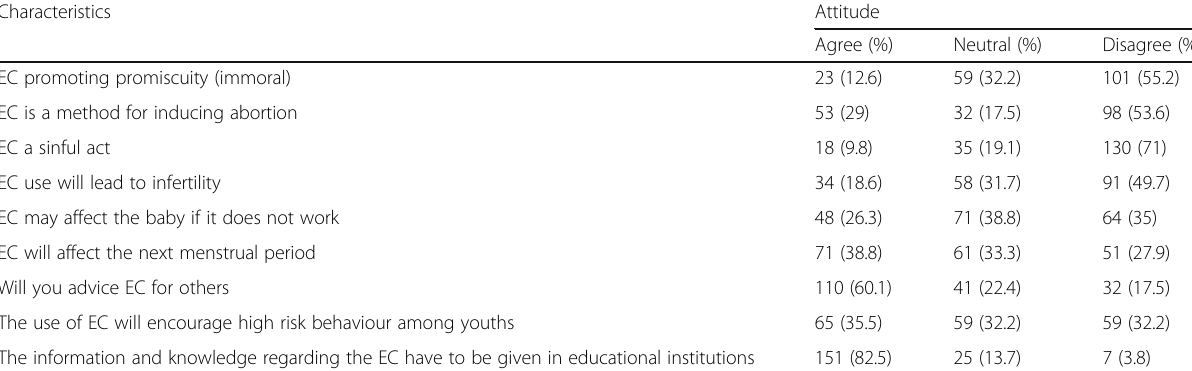
Table 4 Attitude of college students towards the emergency contraception ( n -183) Characteristics